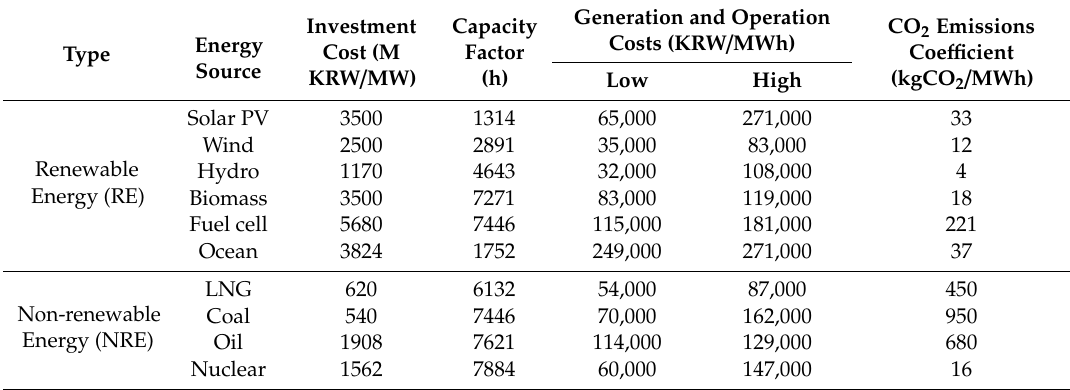
Table 4. Investment, capacity factor, generation and operation costs, and CO 2 emissions coe ffi cient.